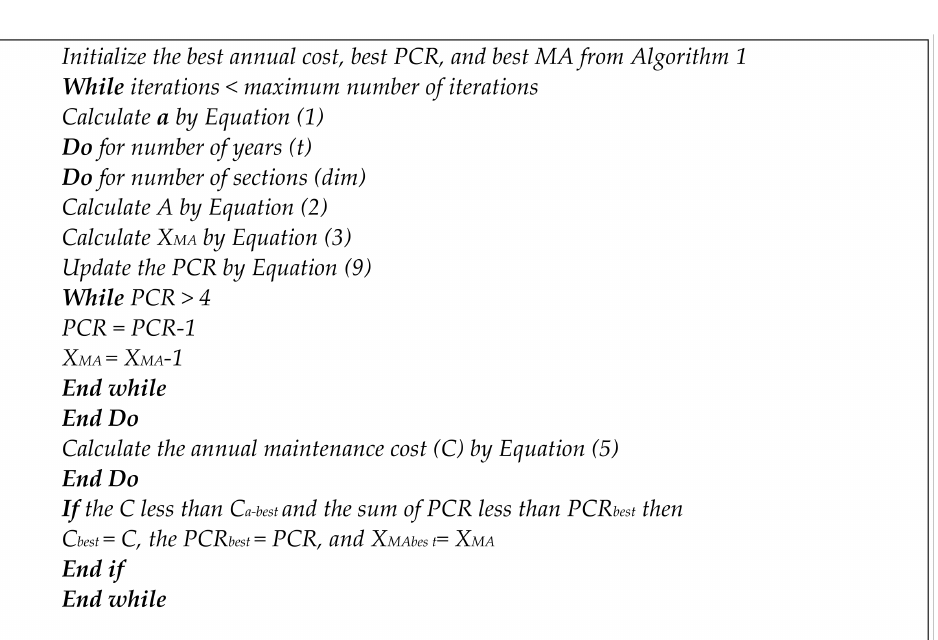
Figure 2. Pseudo-code of PCR initialization.